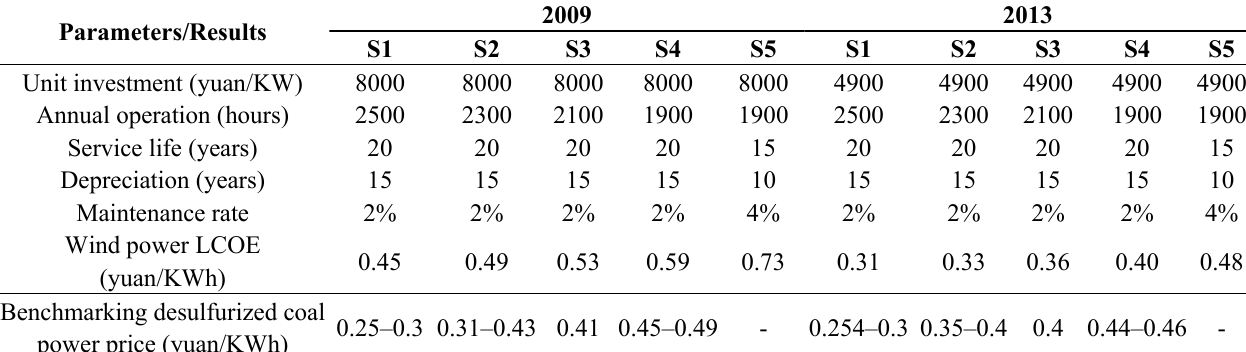
Table 6. Estimated LCOEs of wind power in China, 2009 and 2013 cases.